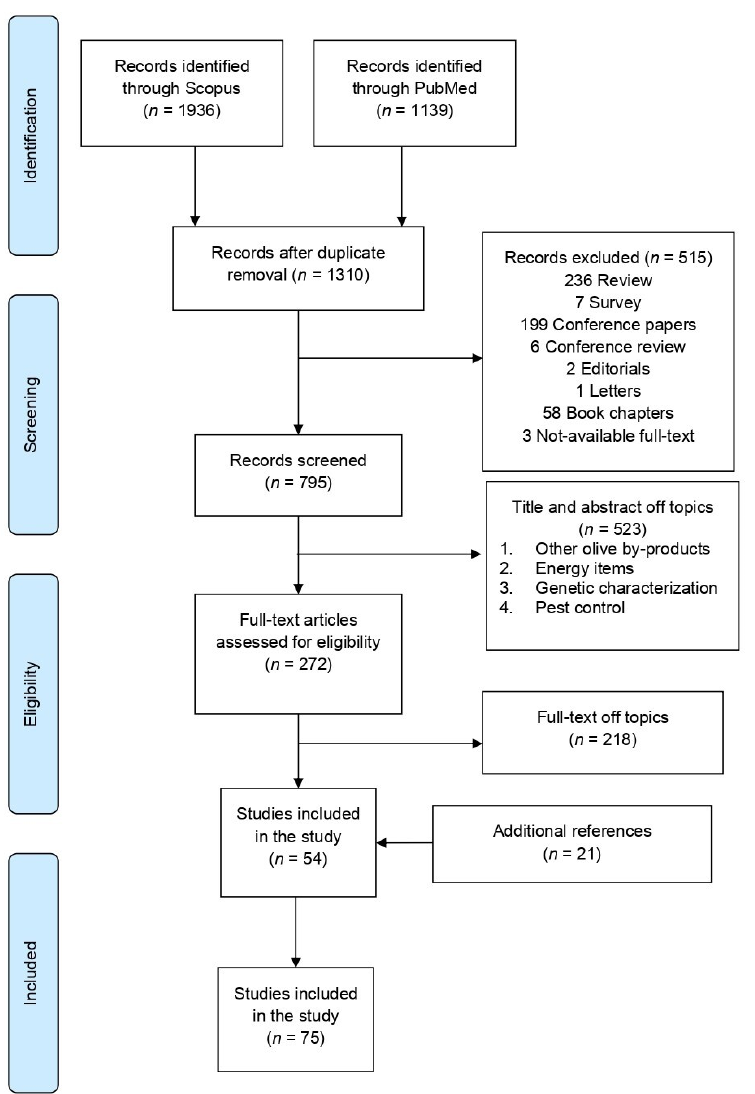
Figure 1. Flow diagram of the systematic review literature search results based on PRISMA statement.